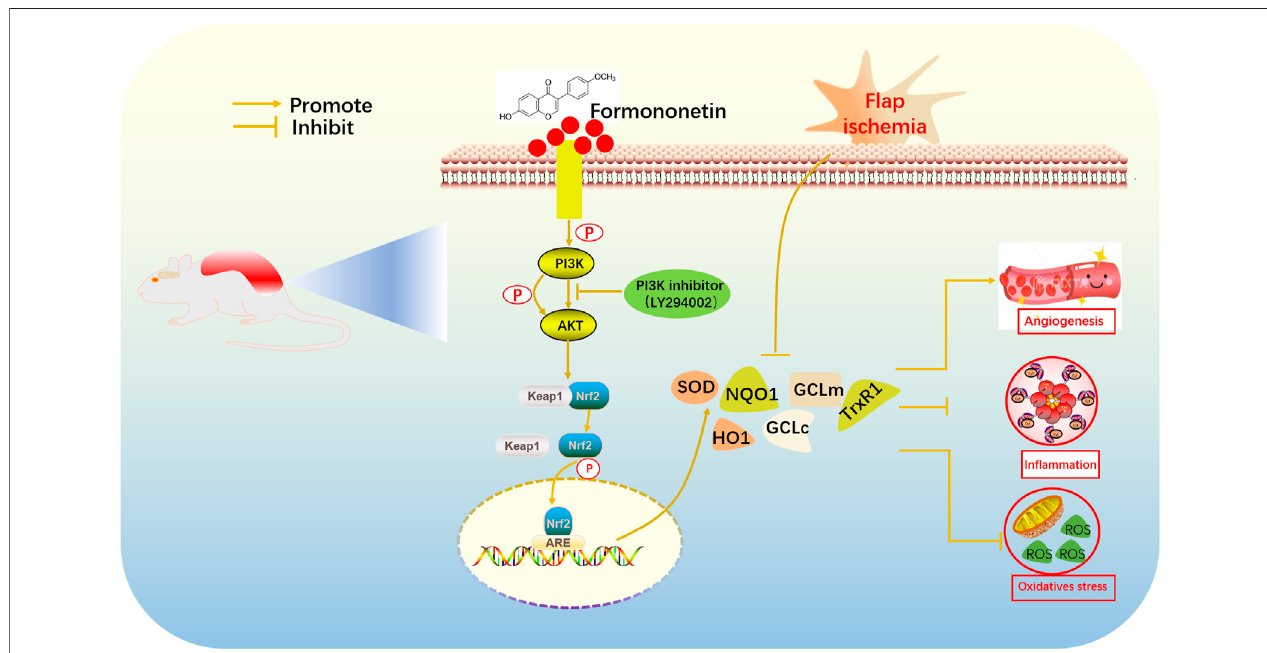
FIGURE 9 | Molecular mechanisms of antioxidant property by